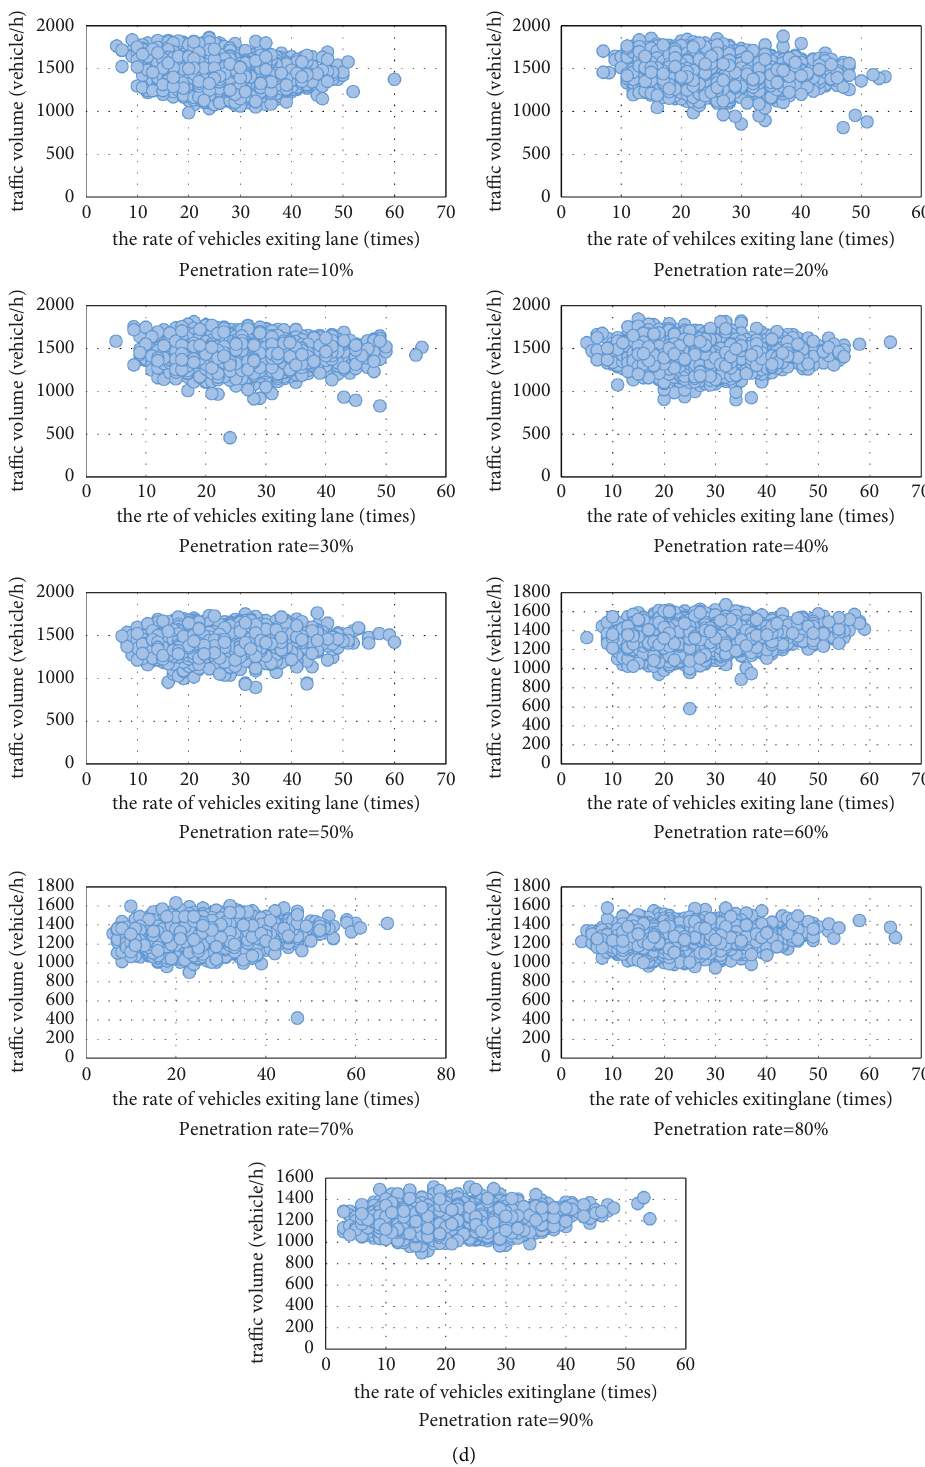
Figure 10: The relationship between traffic volume and the rate of vehicles exiting lane under different ratios of autonomous driving vehicles in different lanes. (a) Relationship diagram of lane 1. (b) Relationship diagram of lane 2. (c) Relationship diagram of lane 3. (d) Relationship diagram of lane